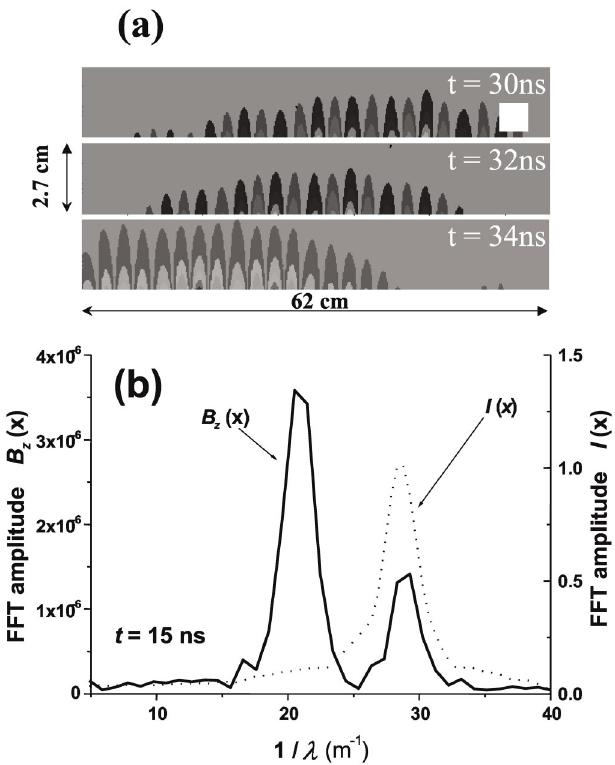
FIG. 8. (a) B ( x ) near the grating at three different times, z showing an approximate period of 4.8 cm, and indicating a slow movement in the negative x direction. (b) FFT of B curve, with two peaks) compared to FFT of current (dashed curve, one